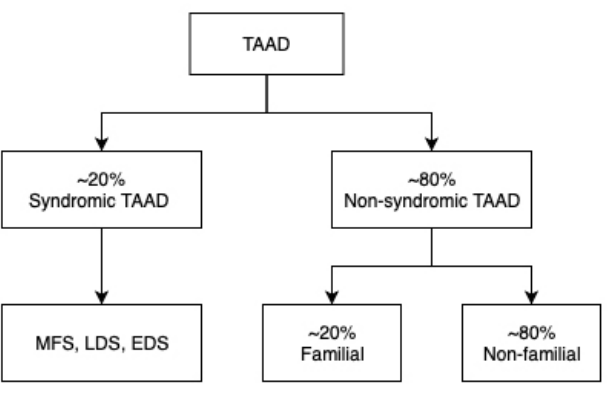
Fig. 4 – Classification of thoracic aortic aneurysm and dissection (TAAD) where percentage values refer to approximate